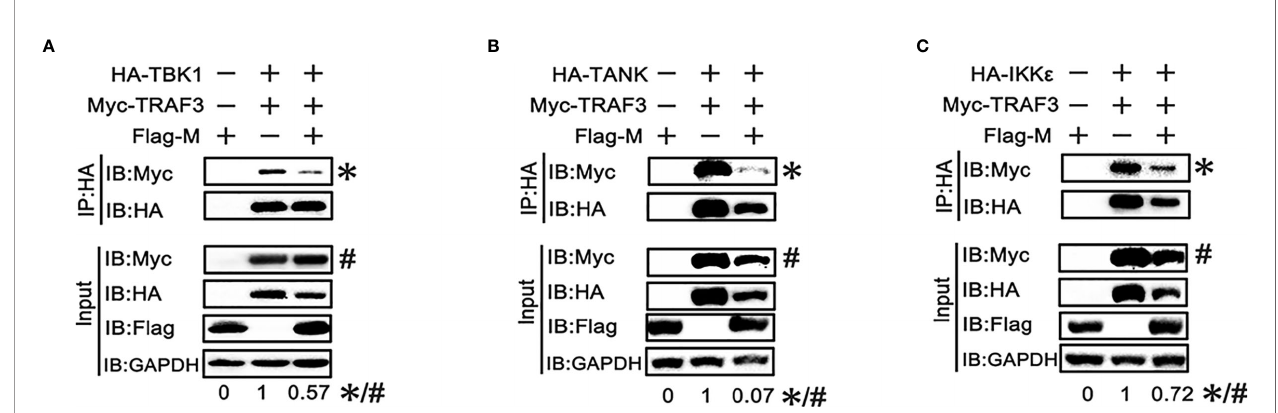
FIGURE 5 | SRAS-CoV-2 M impedes the formation of TRAF3 – TANK – TBK1 complex. (A – C) HEK293T cells were co-transfected with Myc-TRAF3, together with HA-tagged TBK1 (A) , TANK (B) , IKK ϵ (C) with or without Flag-M for 24 h. The cell lysates were harvested and immunoprecipitated with anti-HA antibody. The cell lysates and the immunoprecipitants were analyzed by immunoblot. The relative band intensity (*/#) of co-immunoprecipitated TRAF3 in (A – C) was measured using ImageJ software.